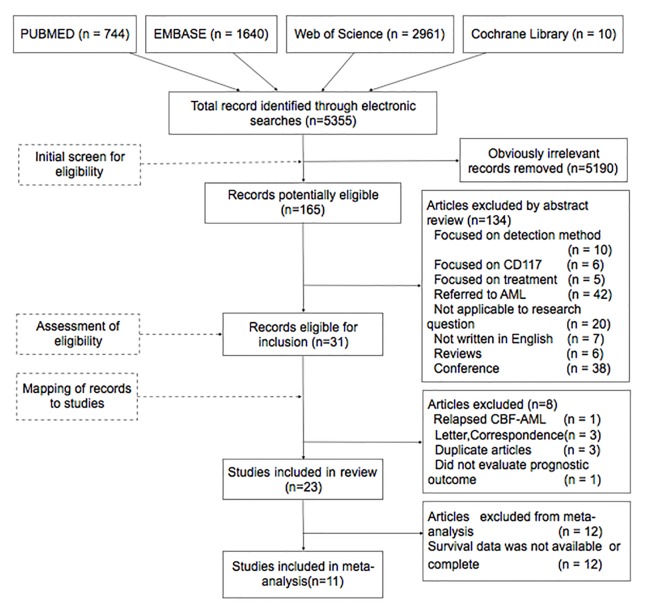
Study flow chart.